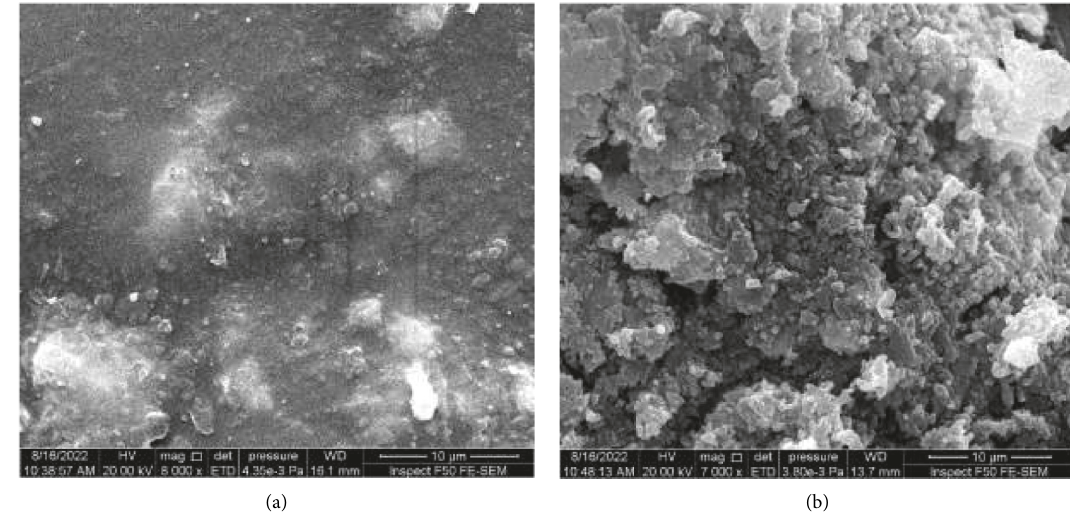
Figure 4: SEM micrographs of (a) blank biobased epoxy and (b) bioepoxy/FF/3wt%SS nanocomposite.